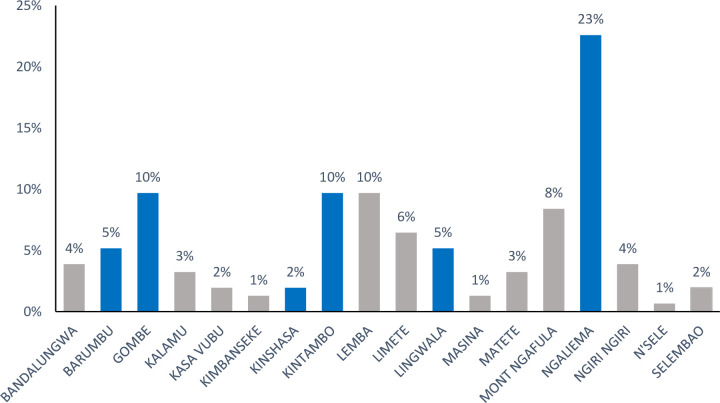
Distribution of COVID-19 patients according to their location in the province of Kinshasa.Municipalities within Clinique Ngaliema catchment area are presented in blue and others in grey.